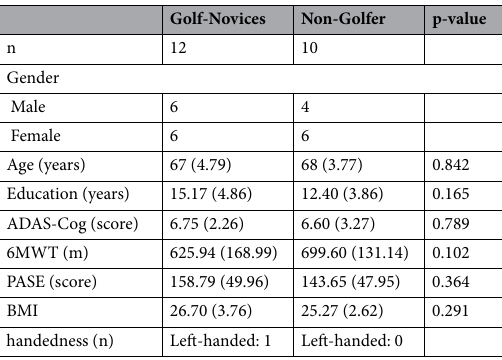
Table 1. Baseline characteristics of the participants, presented as means with standard deviation, except for gender and handedness. Group differences were tested with the Mann–Whitney U test. ADAS-Cog Alzheimer’s disease Assessment Scale-Cognitive Subscale, BMI Body Mass Index, PASE Physical Activity Scale for Elderly, 6MWT 6-min-walk test, BMI body-mass-index.